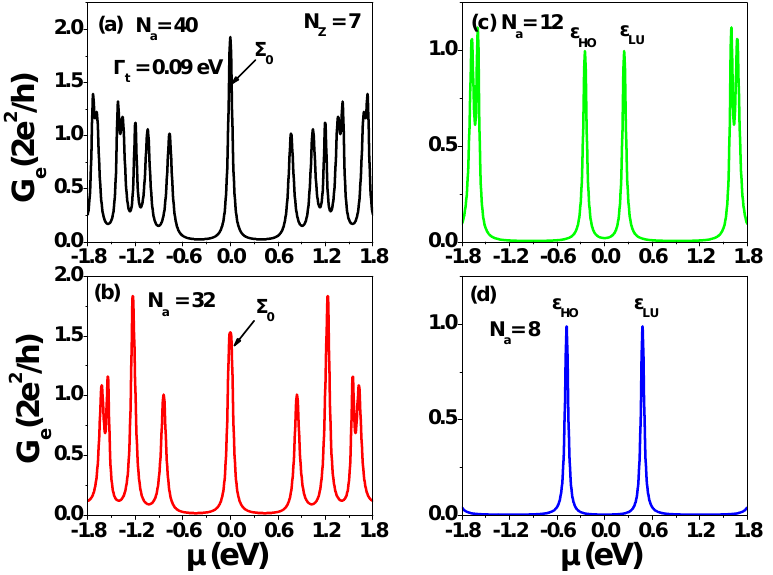
Figure 2. Electrical conductance, G e , of a finite GNR with armchair edges coupled to the electrodes at k B T = 0 as a function of the chemical potential, µ , for various widths with ( a ) N a = 40, ( b ) N a = 32, ( c ) N a = 12, and ( d ) N a = 8. N z is fixed at 7. Here, we have adopted an electron tunneling rate, Γ t = 90